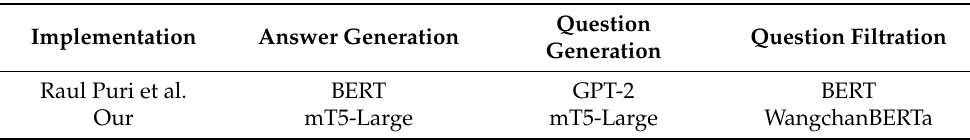
Table 1. Difference of implementation between Raul Puri et al.’s work and ours in the Question Generation pipeline.